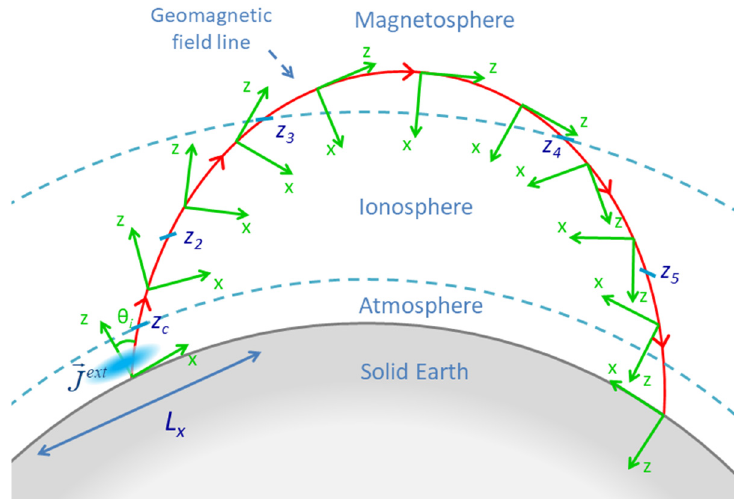
Figure 3. Adiabatically rotated coordinate frames (c.f.) in the case of closed geomagnetic field lines. The points are as follows: z c ≈ 70 km is the boundary between the upper atmosphere and the ionosphere, z 2 ≈ 300 km is the point in the upper ionosphere where the adiabatic rotation of the locally rectangular coordinate frames occurs, z 3 ≈ 600 km is the point in the lower magnetosphere where the local c.f. is aligned along the geomagnetic field line, z 4 is the point in the lower magnetosphere where the inverse rotation of c.f. starts, z 5 is the point in the upper ionosphere where OZ axis of the local c.f. is directed perpendicularly downwards to the Earth’s surface near the return region. L x is the horizontal region of simulations, j ext is the density of external current.